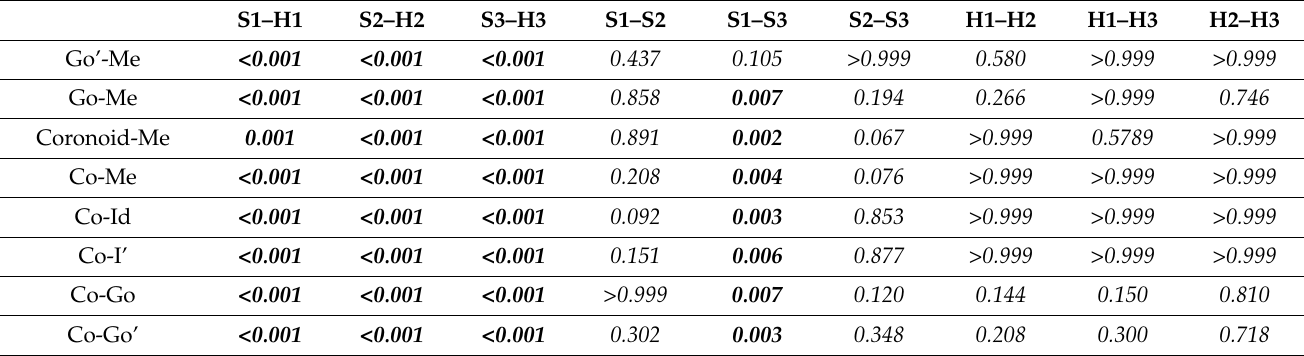
Table 6. Results for all variables measured for the linear measurements ( p values). Differences related to diet and generation were assessed using regression analyses (bold font denotes a statistically significant